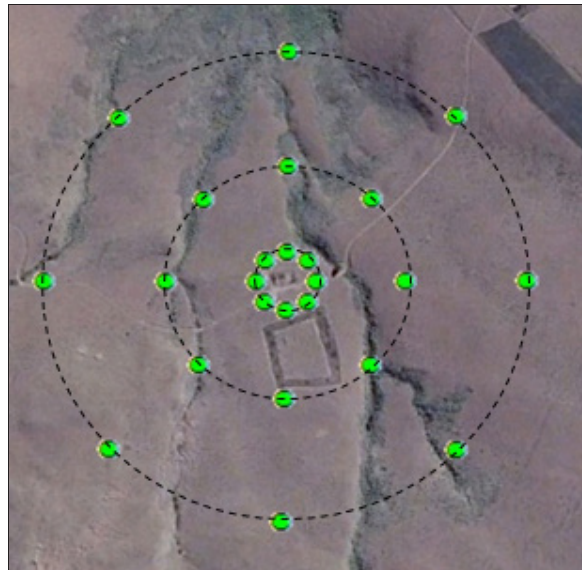
Figure 3: Calibration sampling points along three radial rings extending outwards from the cosmic ray probe (at 25 m, 100 m and 200 m). At each sample point, soil samples were taken at different depths.